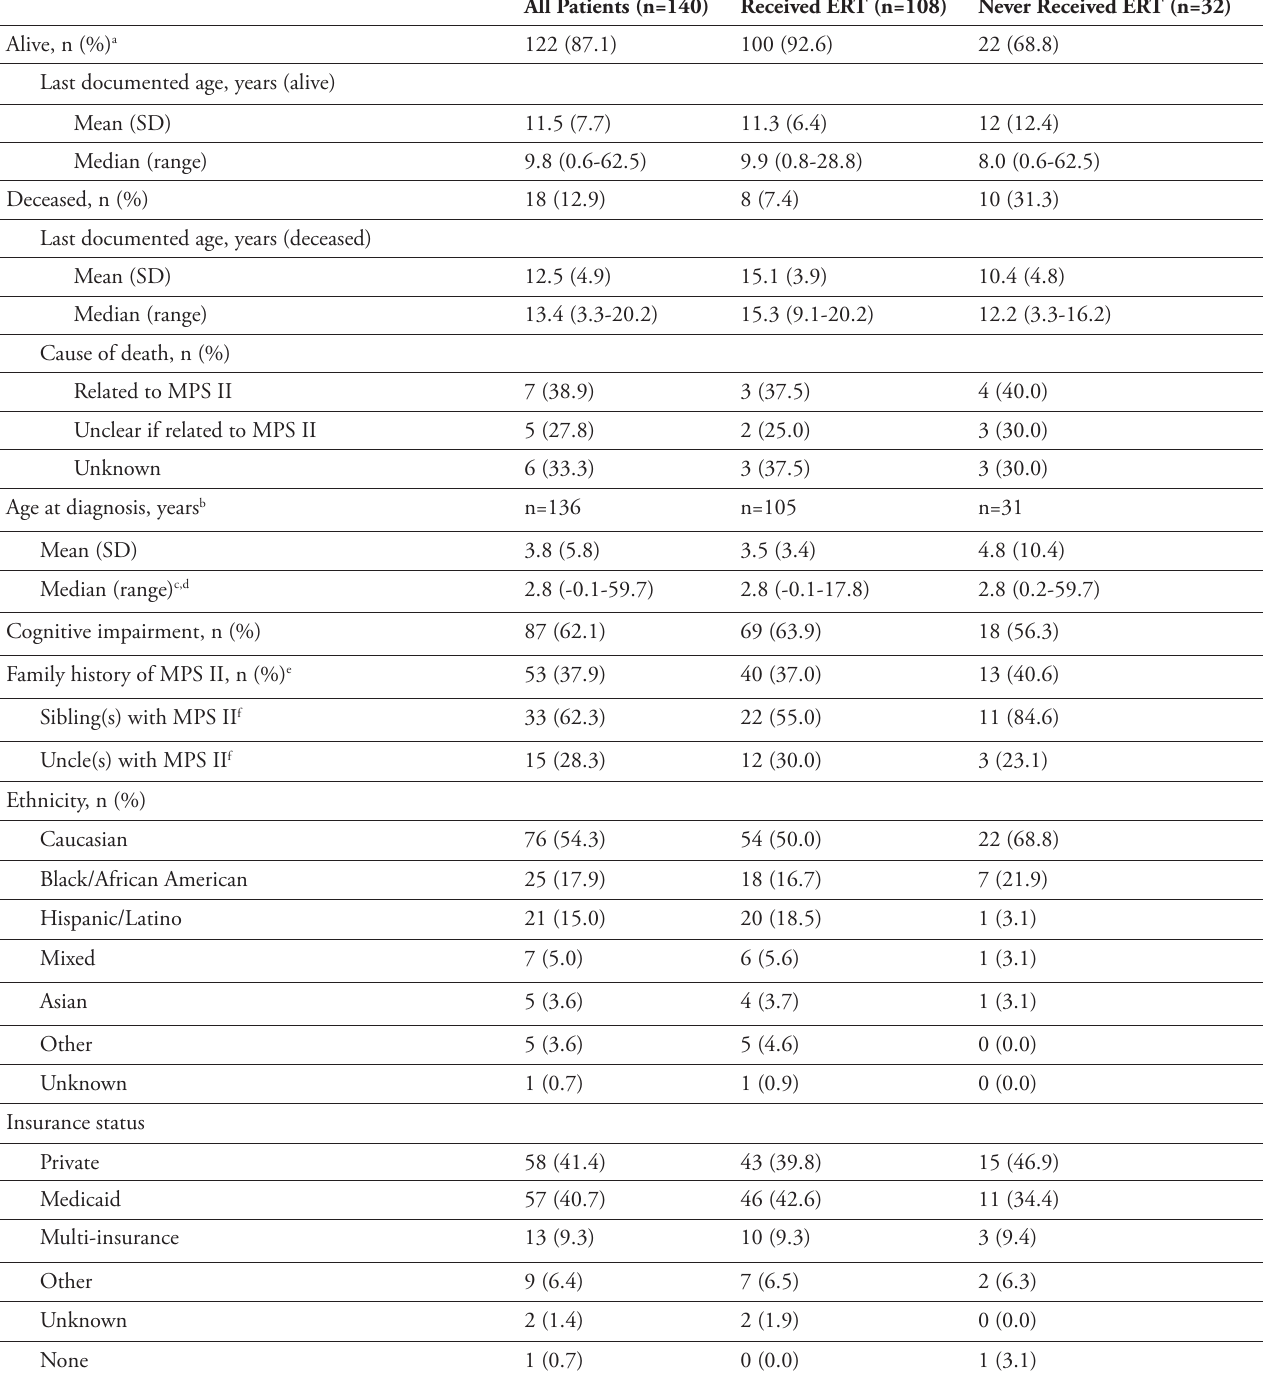
Table 1 . Summary of Patient Characteristics for All Patients and Stratified by ERT Status